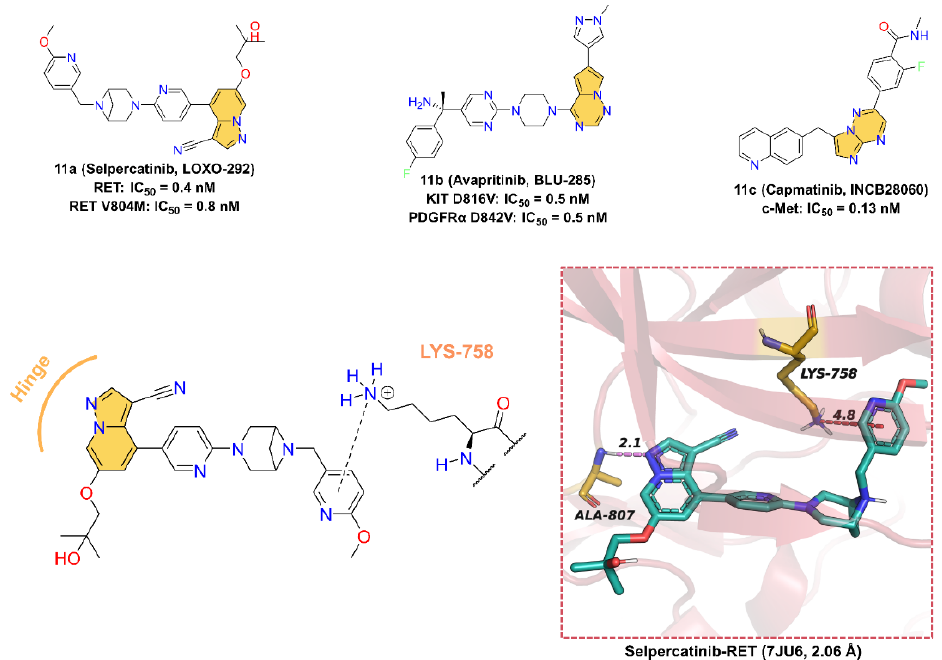
Figure 11. Two-dimensional structures of Selpercatinib , Avapritinib , and Capmatinib together with the binding pattern of Selpercatinib and RET.